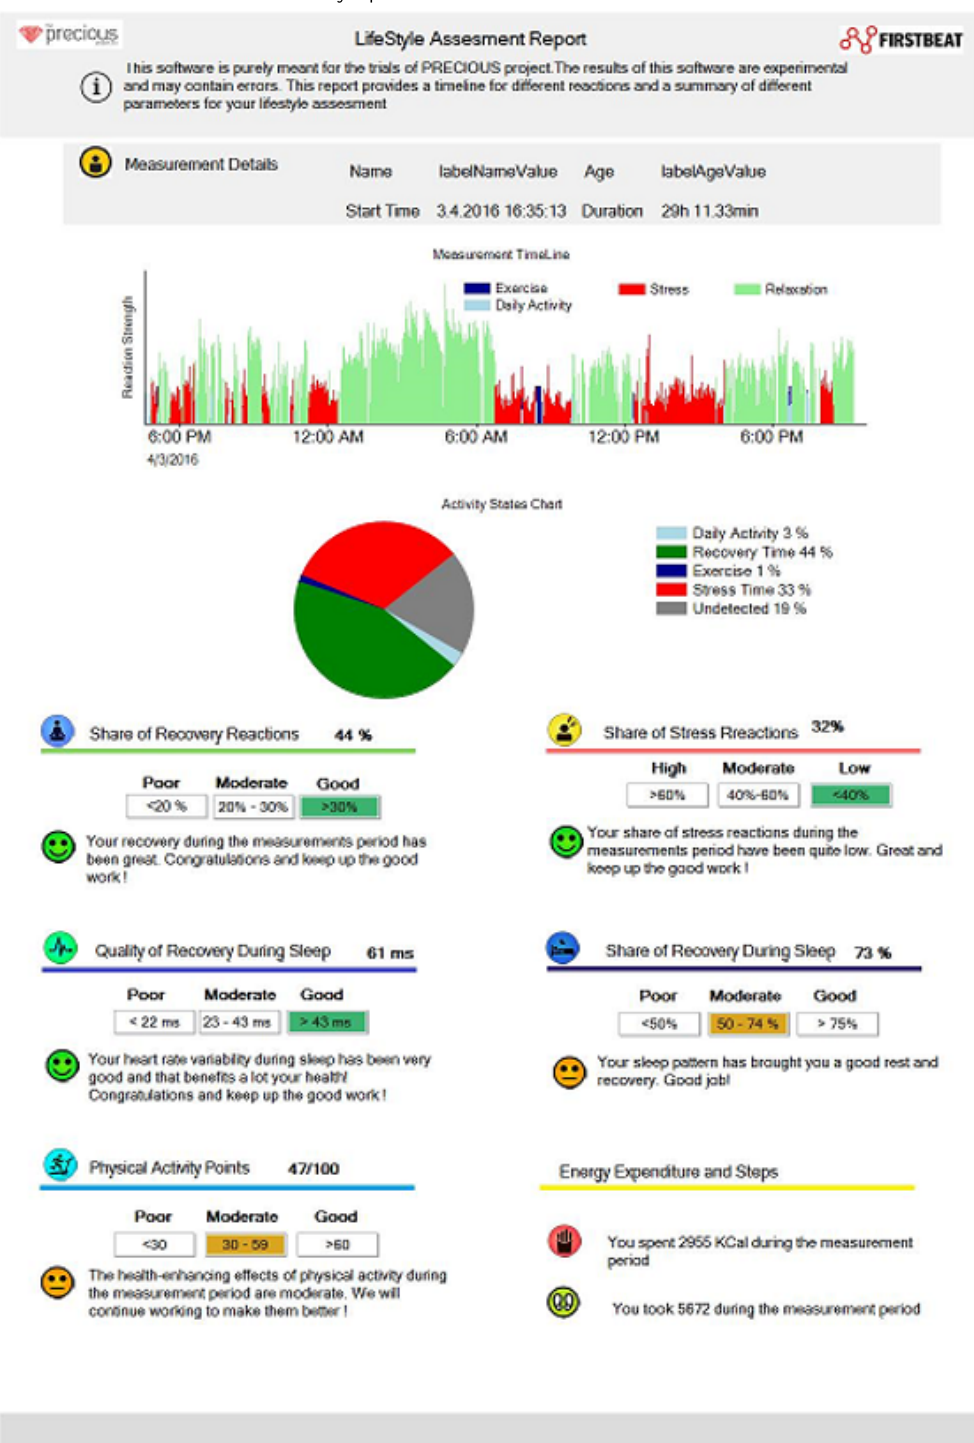
Figure 9. Example view of Firstbeat heart rate variability report for